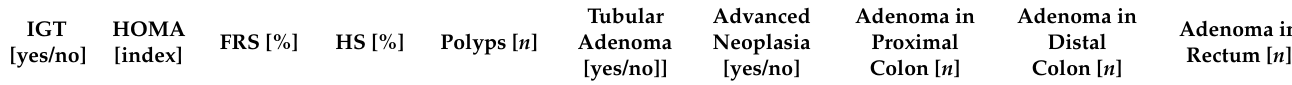
Table 7. Correlation matrix, the upper number indicating Spearman’s rho, the lower indicating the p